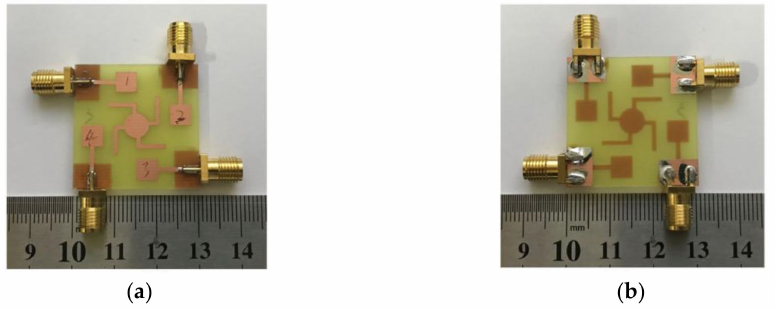
Figure 2. MIMO antenna with PDE: ( a ) front view; and ( b ) back view. (Results from Yang and Zhou,